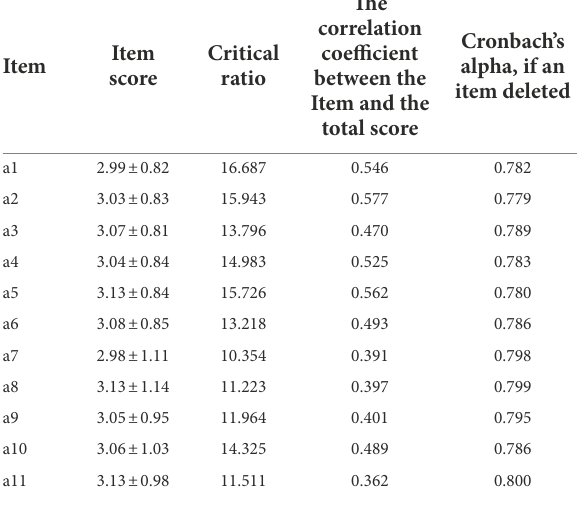
TABLE 2 Item analysis for the Chinese version of the ATREND